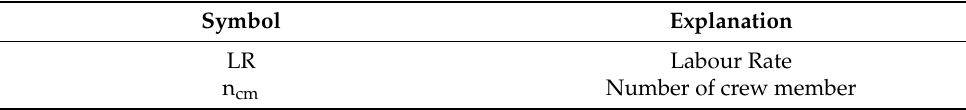
Table 10. Crew cost symbols